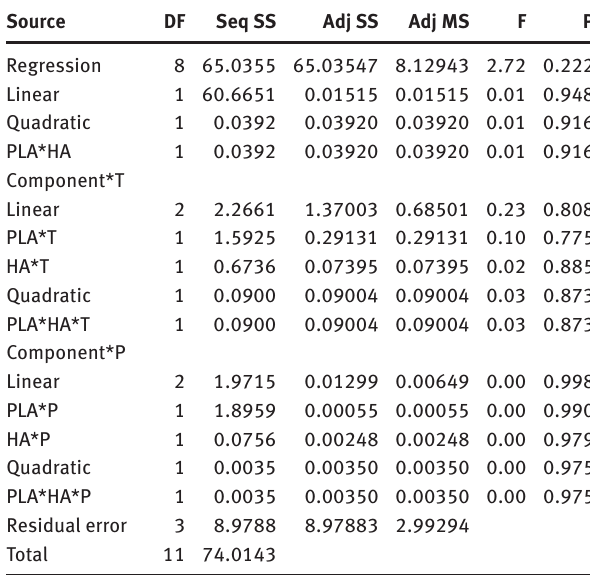
Table 11: Variance analysis of flexural strength.